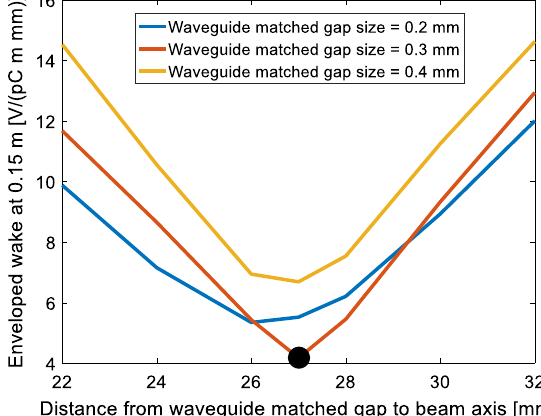
FIG. 13. Dependence of wakefield suppression ( Wy ) on the waveguide matching step ( w in Fig. 6); the solid point represents m the optimum choice.